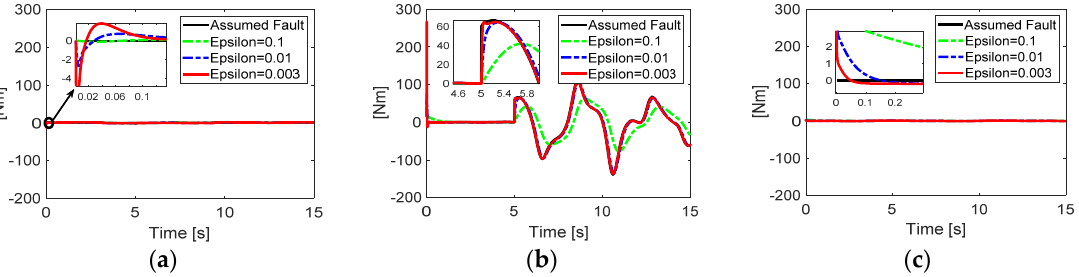
Figure 2. Fault estimation results with a single fault at Joint 2 with the di ff erent values of ε . ( a ) Joint 1; ( b ) Joint 2; ( c ) Joint 3.